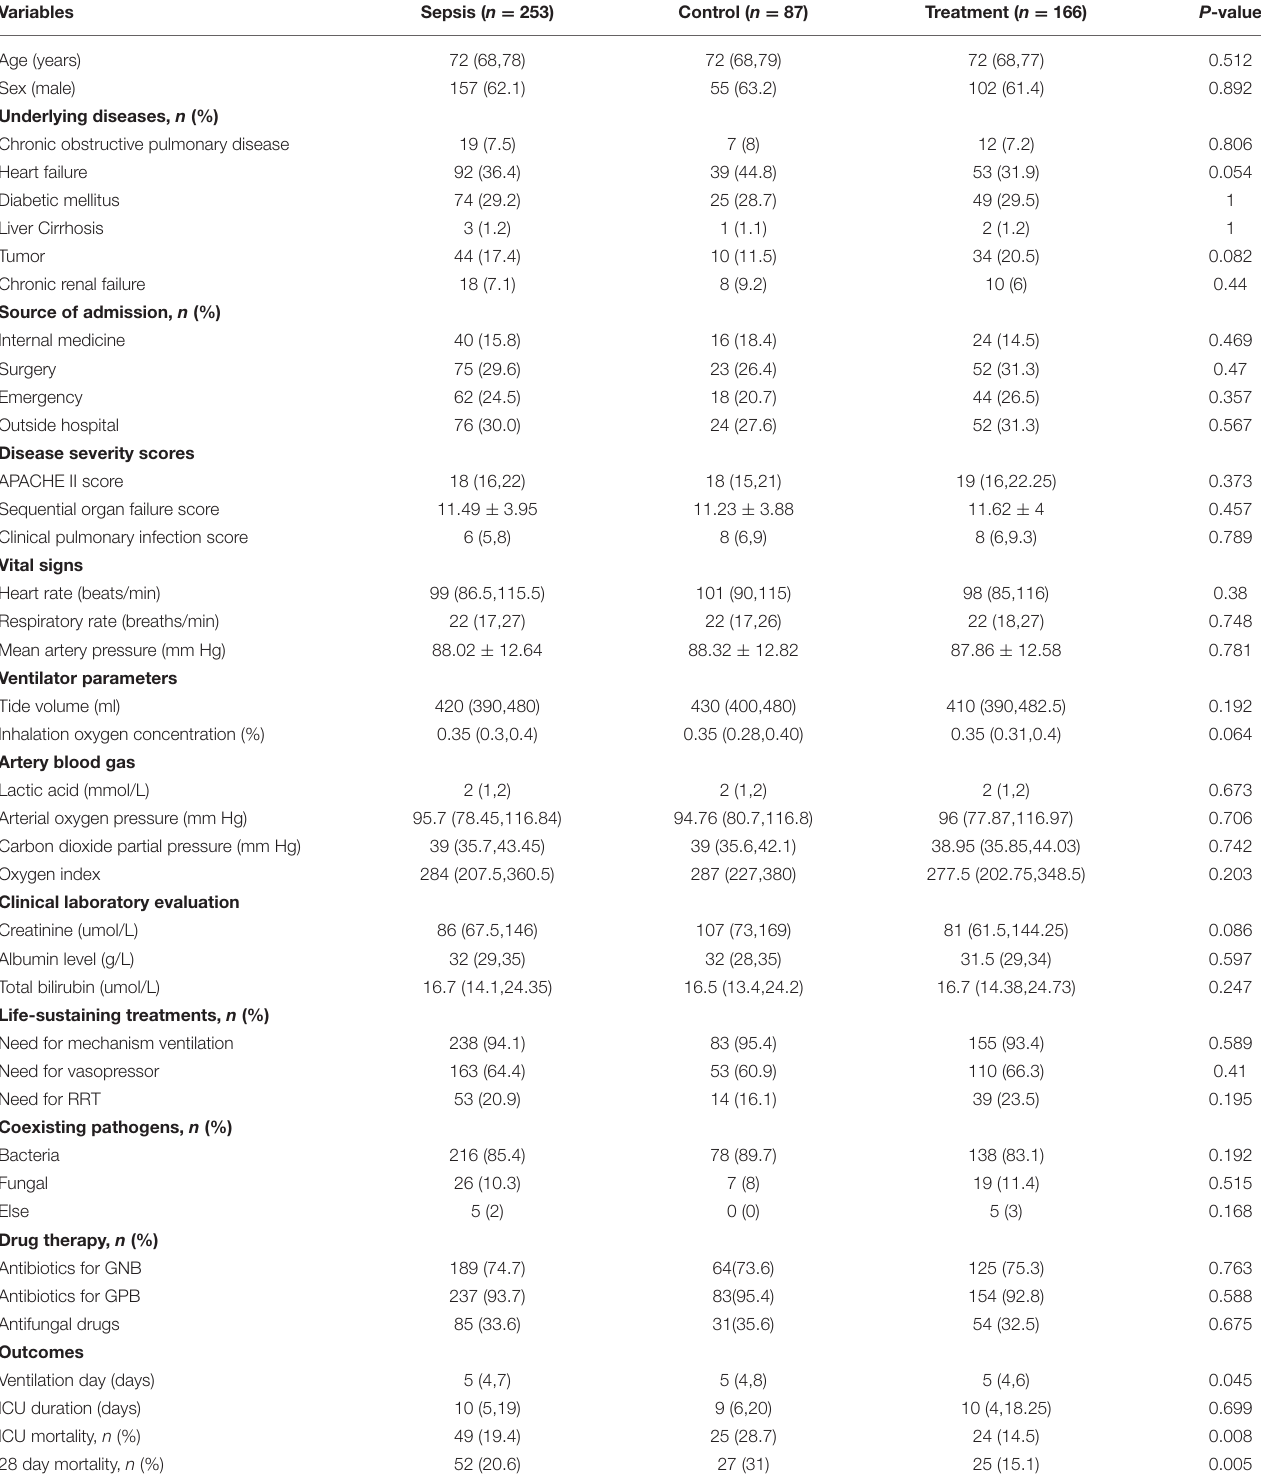
TABLE 1 | Characteristics of patients in the control and treatment groups at ICU admission. Variables Sepsis ( n =